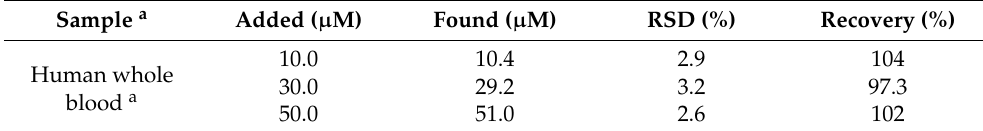
Table 1. Determination of CLZ in human whole blood